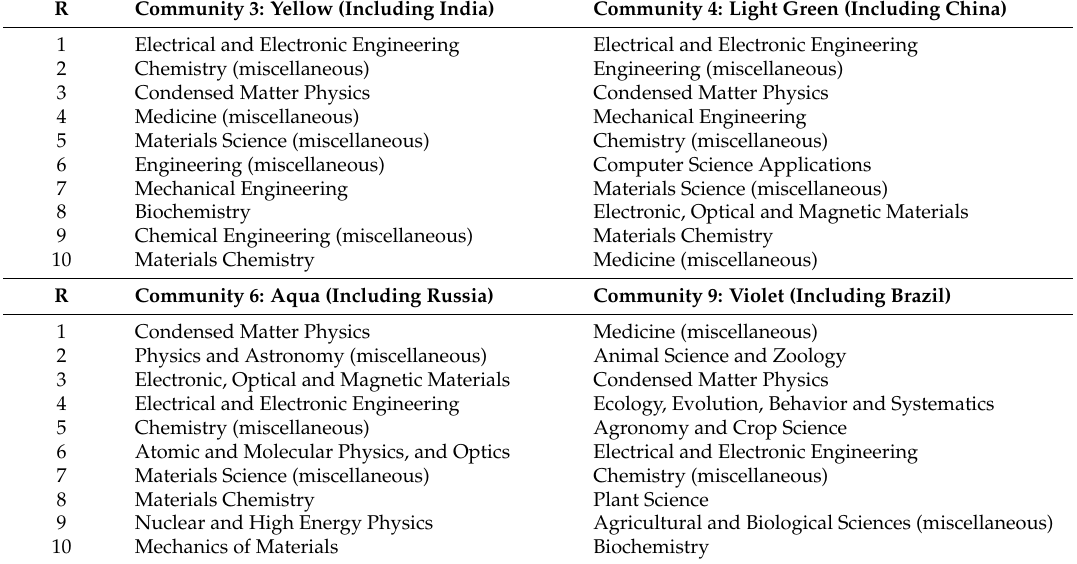
Table 2. Ranking of top 10 ranked areas for each community. We considered the average value of production inside the community for each area. Details of values and data on the other communities are presented in Appendix